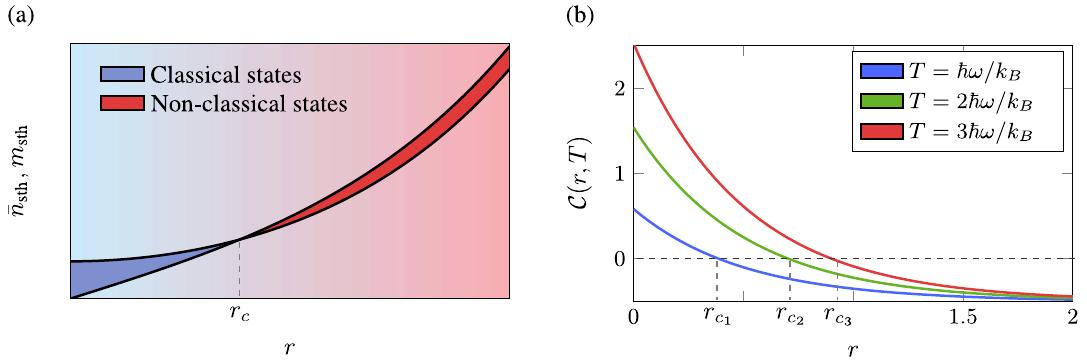
Figure 1. ( a ) A sketch of the parameters ¯ n sth and m sth as a function of the squeezing parameter. Initially, the system is prepared in a thermal state at temperature T and is classical (blue region). By applying a squeezing operation and modulating the squeezing parameter, the system goes from a classical to a non-classical state (red region). This transition occurs with respect to a critical squeezing parameter r c ( T ) . In ( b ) we plotted the classicality as a function of the squeezing parameter for three different temperatures. Observe that after r c the system becomes non-classical, thereby characterising a negative classicality function C < 0